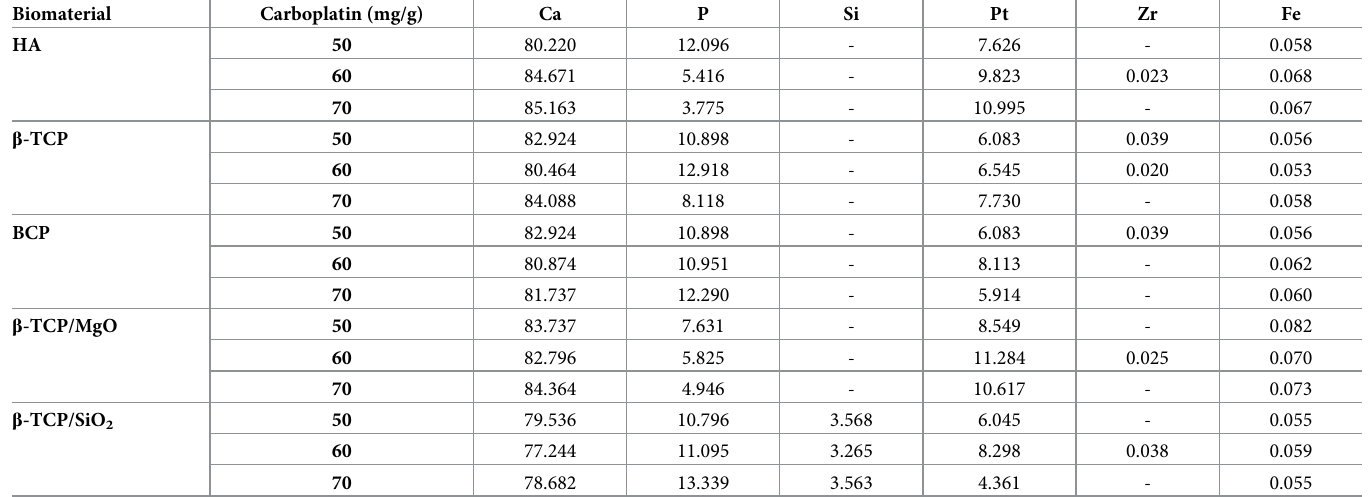
Table 2. X-ray fluorescence spectroscopy of calcium phosphate (CaP)-carboplatin (wt%). Biomaterial Carboplatin